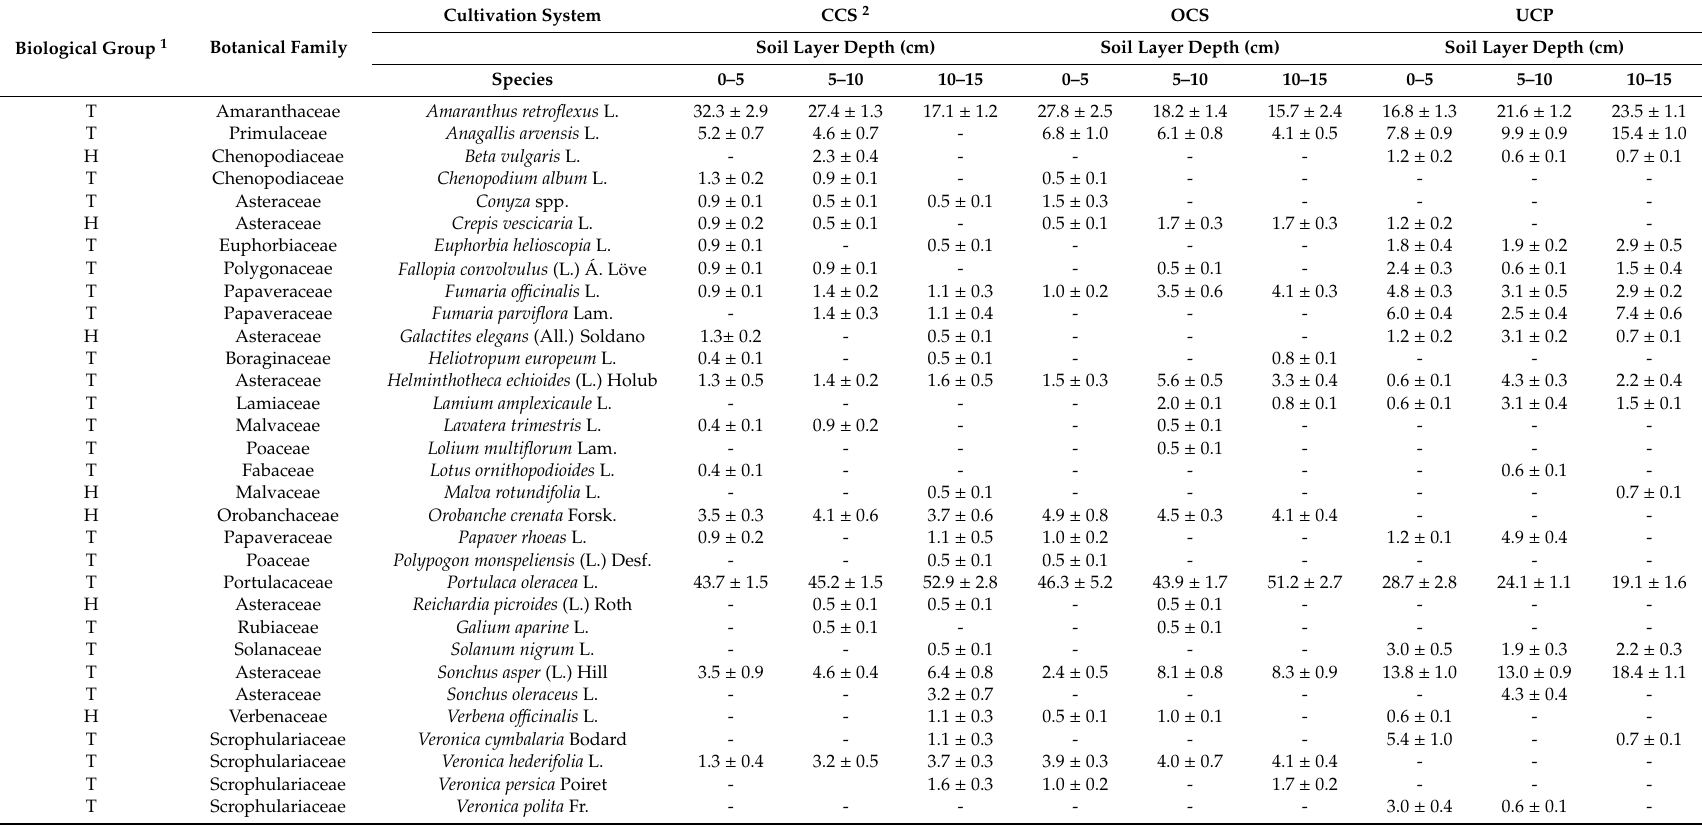
Table 1. Weed seedbank species composition and distribution (% of total seeds) in relation to cultivation system and soil layer depth.